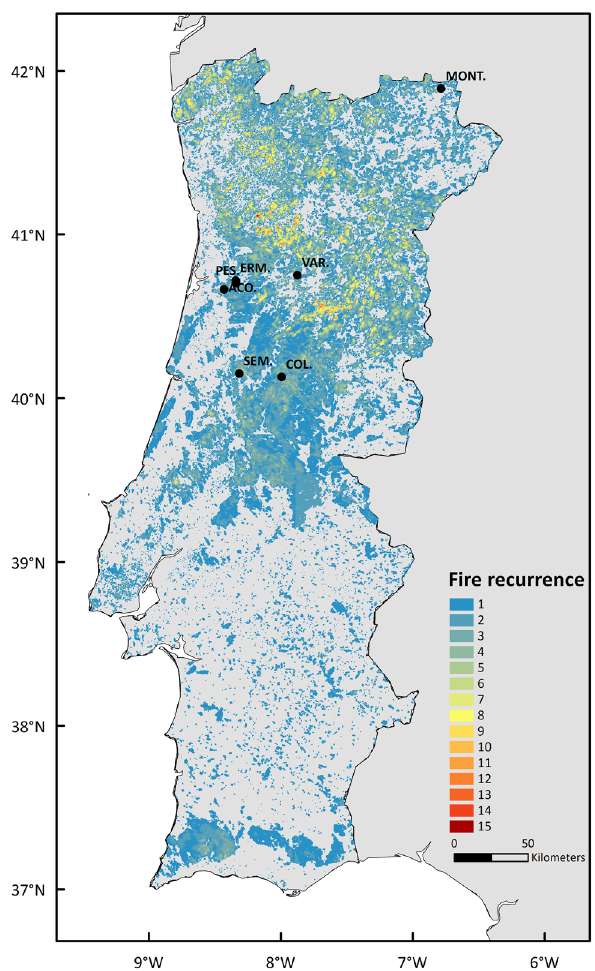
Figure 2. Wildfire recurrence between 1980 and 2018 in Portugal according to the National Mapping Burned Area dataset 28–30 . Points indicate the location of the validation sites defined in Table 2: Montesinho (MONT.), Ermida (ERM.), Pessegueiro do Vouga (PES.), Açores (ACO.), Várzea (VAR.), Semide (SEM.), Colmeal 1 and 2